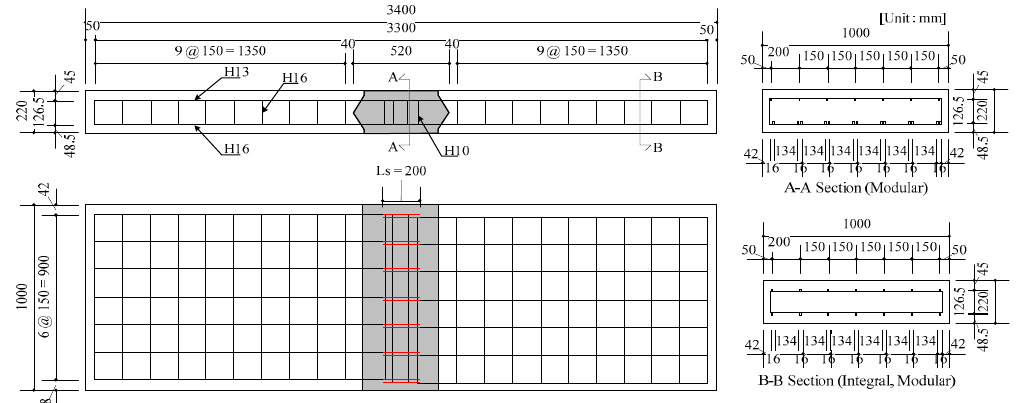
Figure 1. Specifications of the modular specimen.